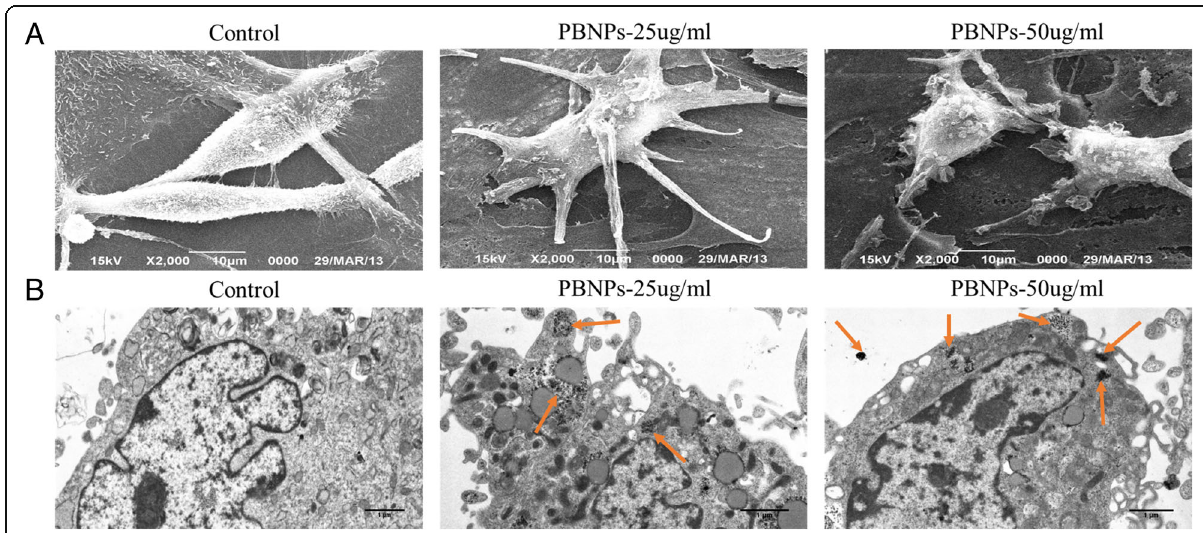
Fig. 2 SEM and TEM images of the C3H10T1/2 cells after the incubation with different concentrations of PBNPs for 48 h. a SEM images. b TEM images. ↑ , intracellularly distributed